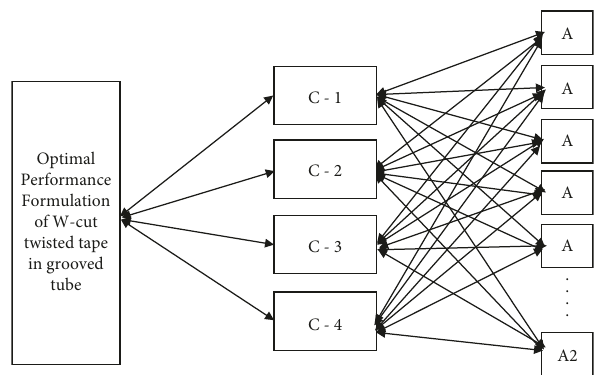
Figure 6: Decision hierarchy for performance prediction of W-cut